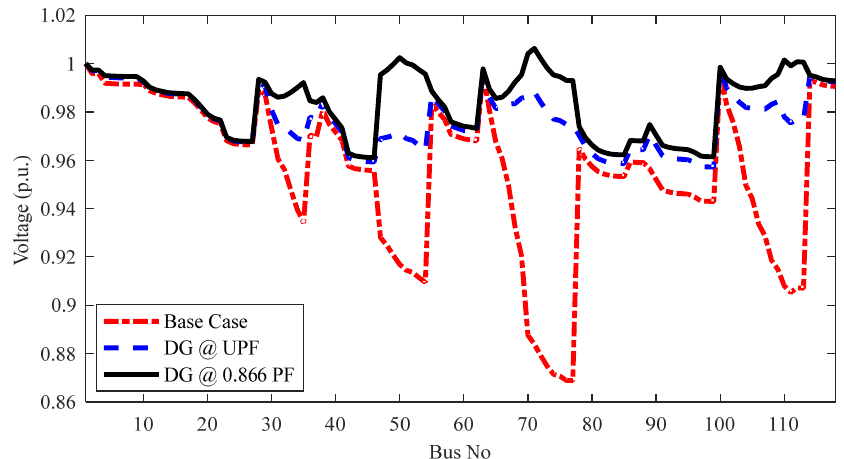
Figure 11. Comparison of the convergence characteristics of the SCA, DEA and O-SCMDEA for both cases of scenario IV of the 118 bus system.